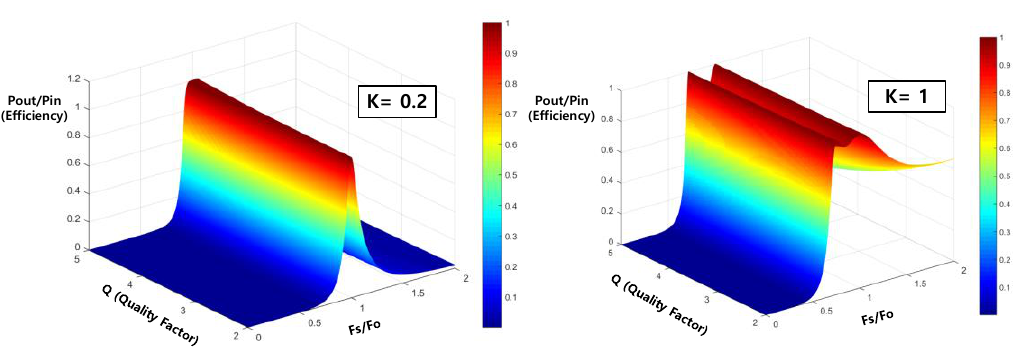
Figure 4. Power gain G p (E ffi ciency) according to load quality factor and ω n ( k = 1, k = 0.2).